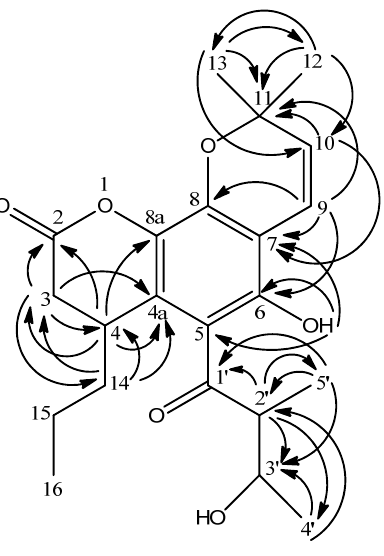
Figure 1. HMBC 2 J and 3 J correlations between 1 H and 13 C in 1